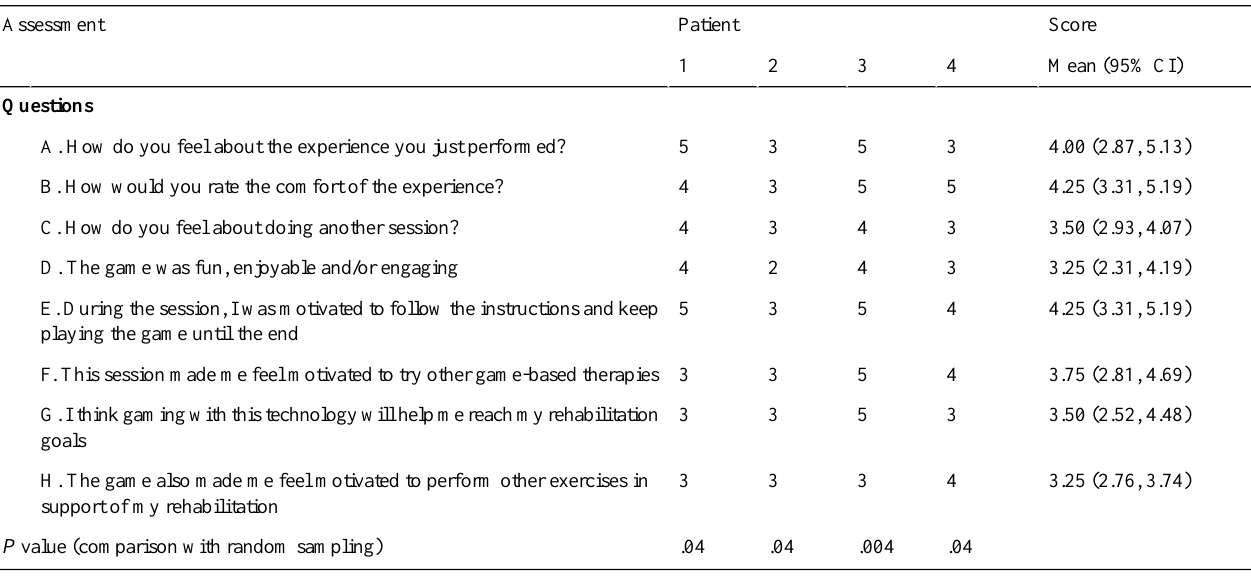
Table 3. Results and response comparison of acceptability questionnaire.